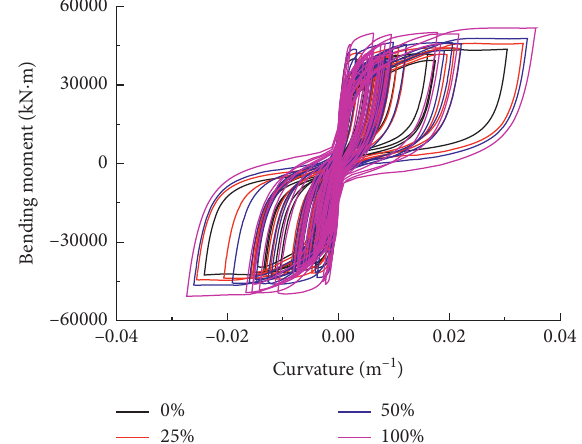
Figure 6: Hysteretic curve of RC/ECC pier with different re- placement rates of high-strength